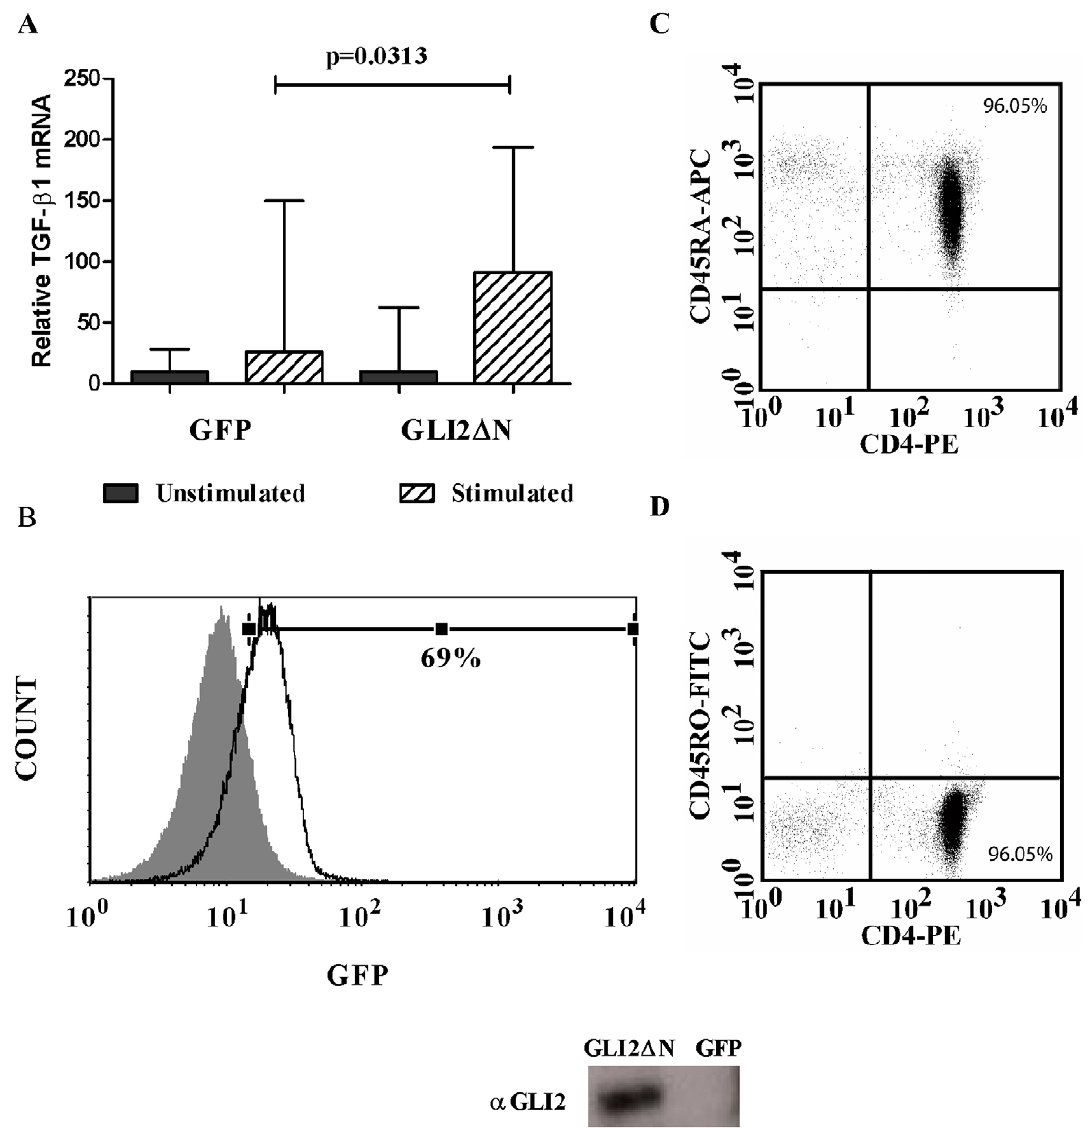
Figure 3. Lentiviral Infection of Naı¨ve CD4 + T cells with GLI2 Activator Increases TGF- b 1 transcription. Naı¨ve human CD4 + T cells were isolated by negative selection and infected with a lentivirus containing a GLI2 D N activator construct or a GFP control. 72 hours post-infection, cellular RNA was collected to measure TGF- b 1 transcripts. (A) Relative TGF- b 1 mRNA was measured by RT-PCR and normalized to 18S rRNA. TGF- b 1 mRNA was significantly increased (n=6, * p=0.0313) in cells infected with GLI2 D N as compared to cells infected with GFP control. (B) The infection efficiency was measured at 69% using a GFP expressing control lentivirus. (C & D) The phenotype of the naı¨ve CD4 + T cells was greater than 95% of the cells at Day 0 were CD4 + CD45RA + CD45RO - naı¨ve T cells. Expression of GLI2 D N was confirmed by Western Blot